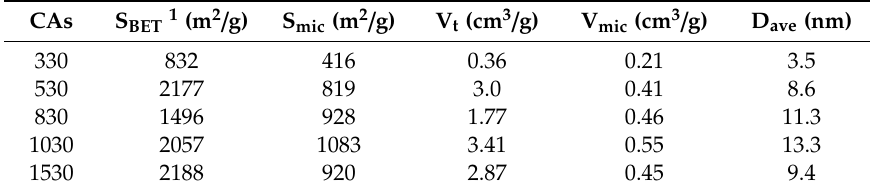
Figure 2. SEM image of different CAs. ( a ) 330; ( b ) 530; ( c ) 830; ( d ) 1030; ( e ) 1530. Table 1. Specific surface area and pore structure parameters of different CAs.